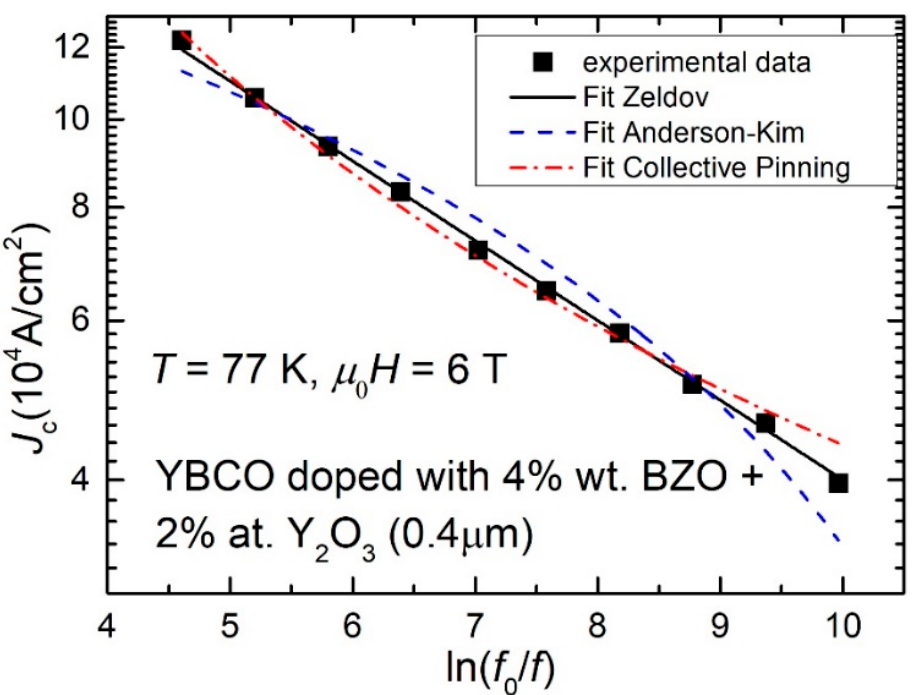
Figure 2. Critical current density J c , at 77 K and in a DC field of 6 T, of a 0.4 µm-thick film of YBCO doped with 4% wt. BZO and 2% at. Y 2 O 3 , obtained from measurements similar to those exhibited in Figure 1 by using Equation (1), as function of AC field frequency f , in a double-logarithmic scale. f 0 in the reformulation of the x-axis is a macroscopic attempt frequency of flux jumps outside the pinning centers of about 10 6 Hz [25]. The dash line (blue) is the best fit with the Anderson–Kim model (Equation (2)), the dash-dot line (red) is the best fit with the collective pinning model (Equation (3)), while the best fit in this double logarithmic plot is a straight line (full line—black), which is compatible with the logarithmic dependence of the pinning potential on probing current proposed by Zeldov et al., as we will prove in Section 3.3.